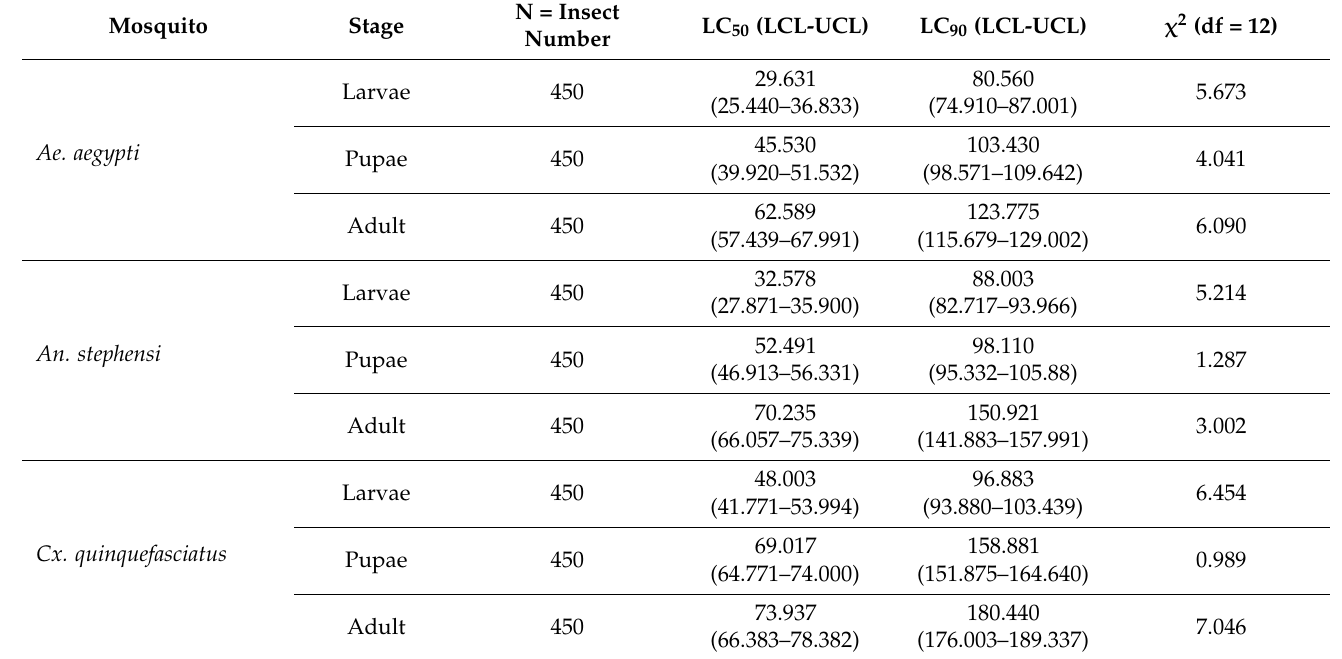
Table 1. Mosquitocidal activities of M. anisopliae ethyl acetate crude extract against larvae, pupae, and adults of three mosquito species at 24 h after